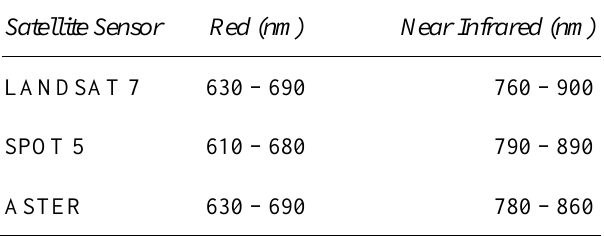
Table 1: Wavelength ranges for the red and the near infrared (NIR) bands of the sensors on Landsat 7, SPOT 5, and